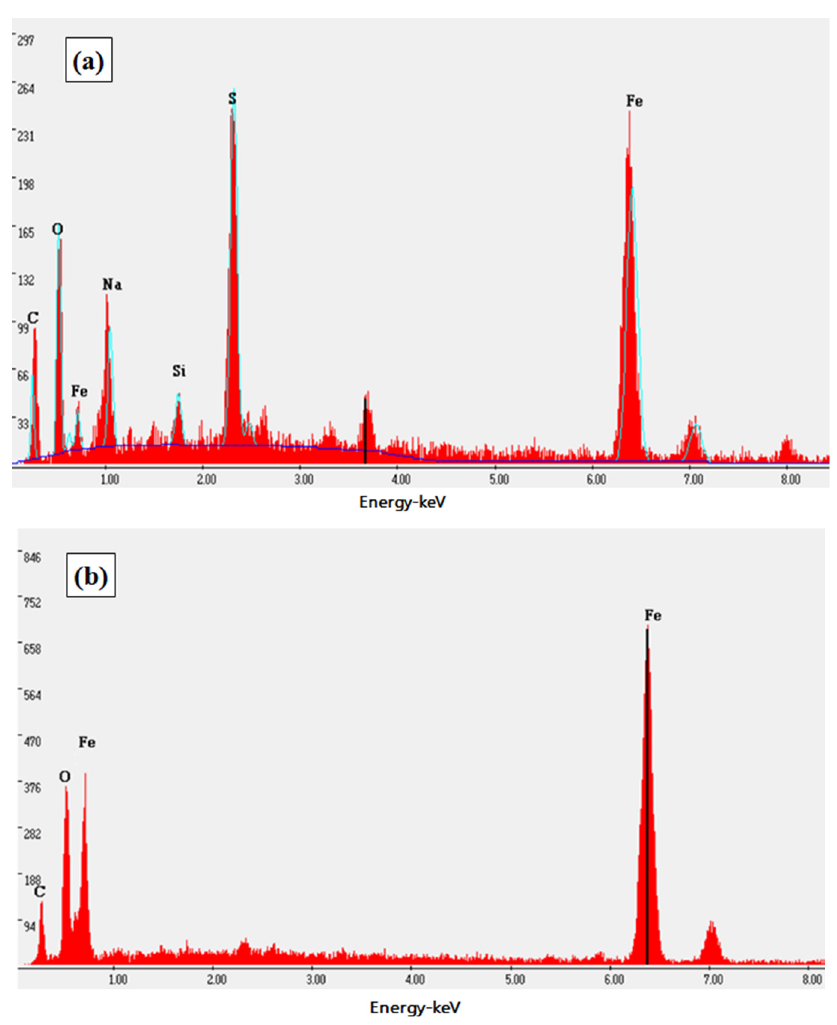
Figure 10. Energy spectrum of prestressed steel wire surface in NH 4 SCN solution: ( a ) corrosion products film, ( b ) original iron oxide film.